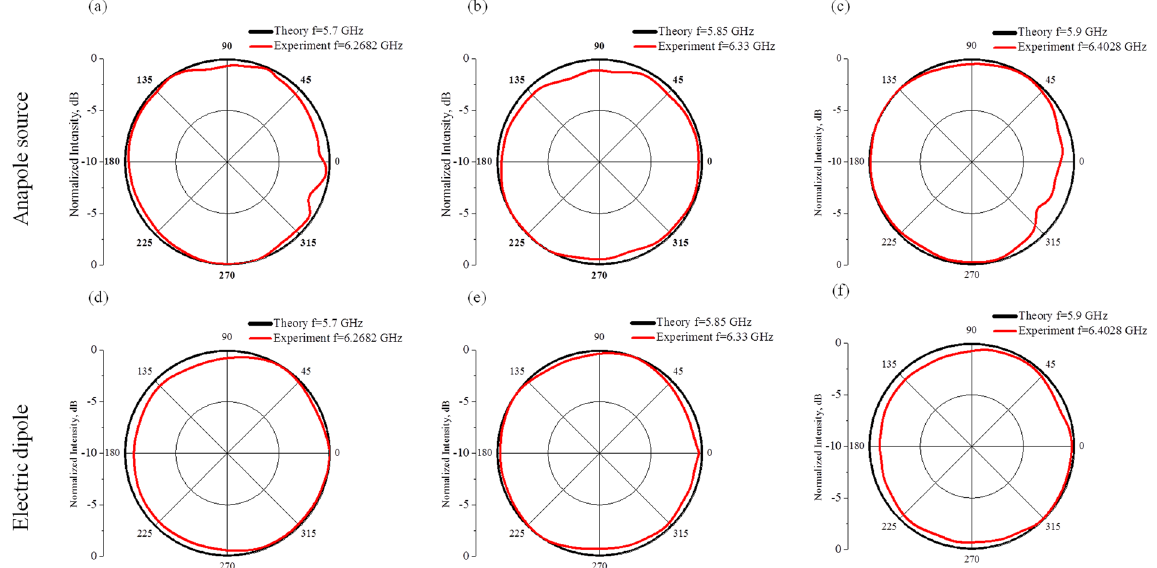
Figure 3. Normalized radiation Patterns (RP) of Anapole source ( a – c ) and Electric dipole, for comparison ( d – f ). Black curve represents results of simulation and red curve is experimental results.